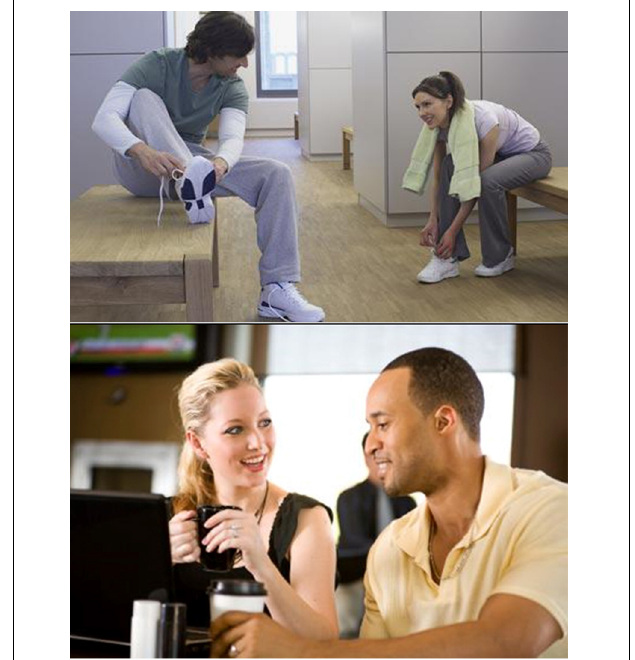
FIGURE 3 | Sample picture used in Experiment